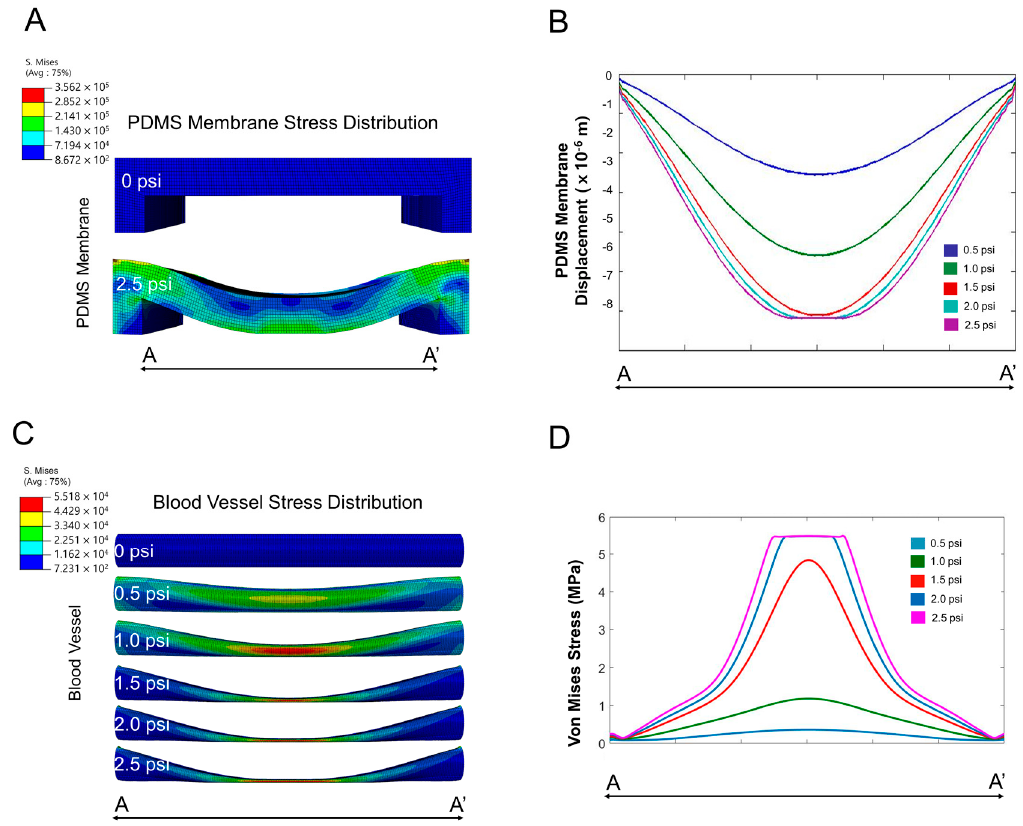
Figure 3. Finite element analysis of the stress distribution of a blood vessel. ( A ) Finite element analysis of a PDMS membrane deforming at 0.0 psi and 2.5 psi, respectively. ( B ) Simulated PDMS membrane deflection plot. ( C ) Finite element analysis of the blood vessel stress distribution according to six different pressures. ( D ) Von Mises stress distribution of a blood vessel.